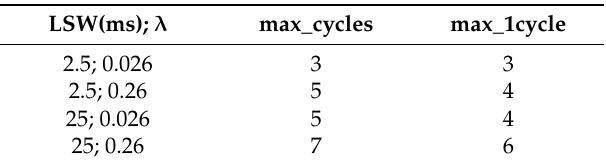
Table 3. Maximum consecutive cycles (max_cycles) with single error and maximum number of errors in one cycle (max_1cycle), for various values of LSW and λ , using p ε = 10 − 16 .